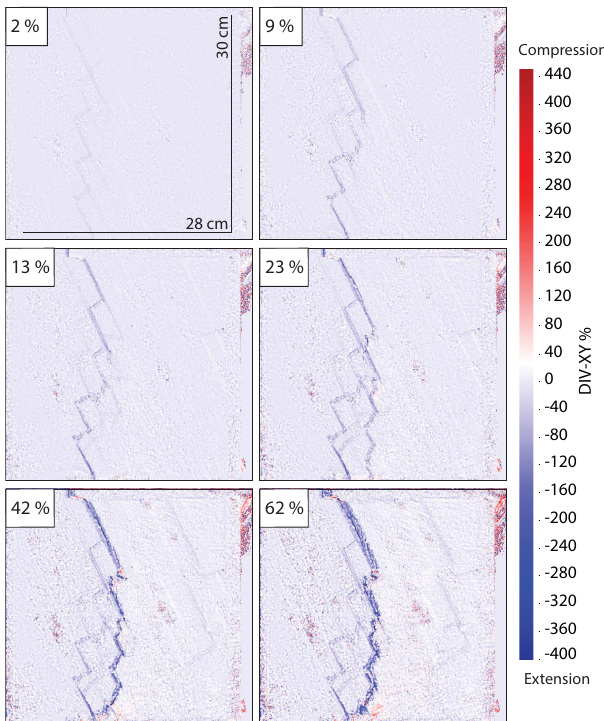
ing the summed up divergence of the displacement field (extension: blue; compression: red). Note how different joints are reactivated at different stages of